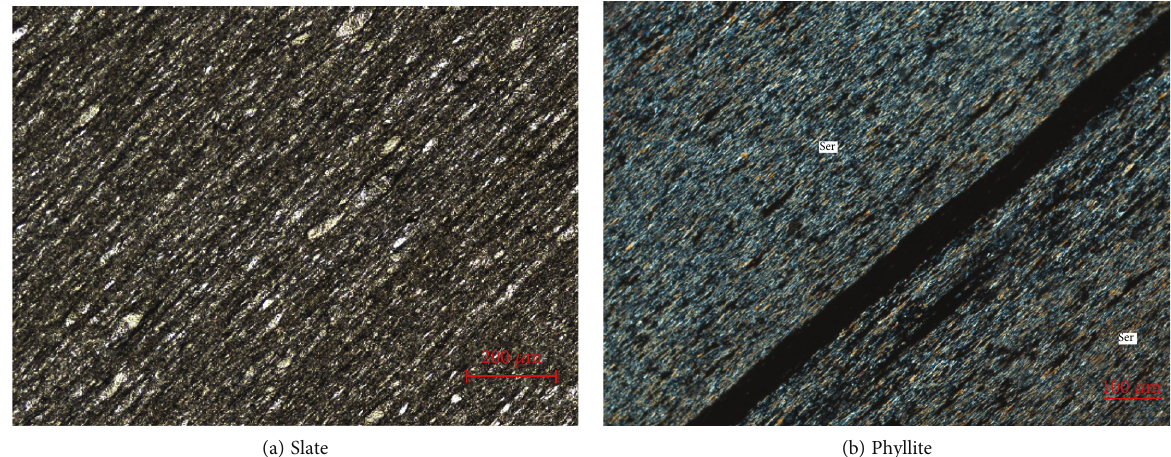
Figure 4: Mirror micrograph of two low-grade metamorphic rock